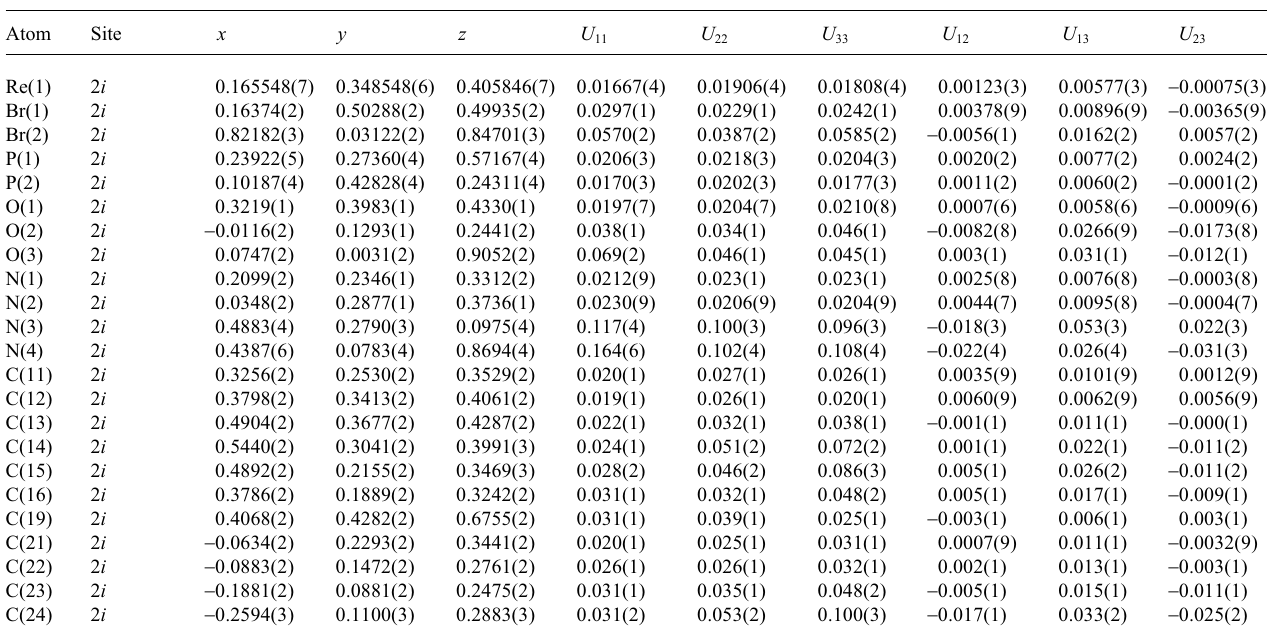
Table 3. Atomic coordinates and displacement parameters (in Å 2 )